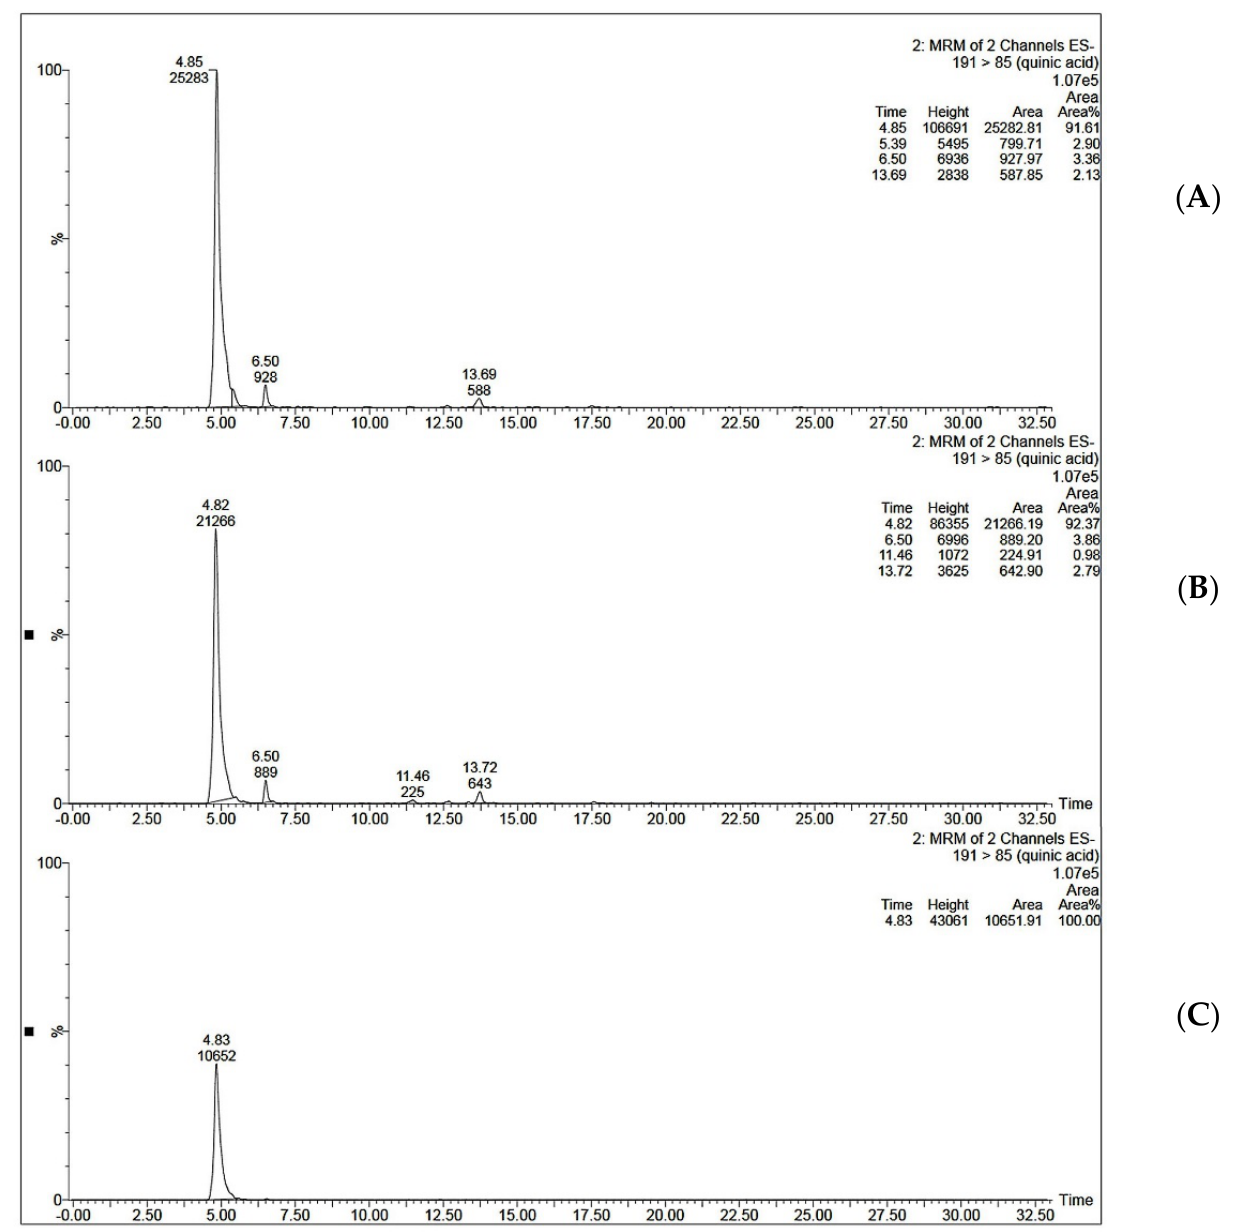
Figure 9. Mass chromatograms of QA ( A ) in 0.25 µg/mL coffee extract dissolved in ethanol: water (97:3 v / v ) before loading to MISPE C, ( B ) the elution fraction obtained from MISPE procedure, ( C ) the elution fraction obtained from NISPE procedure.